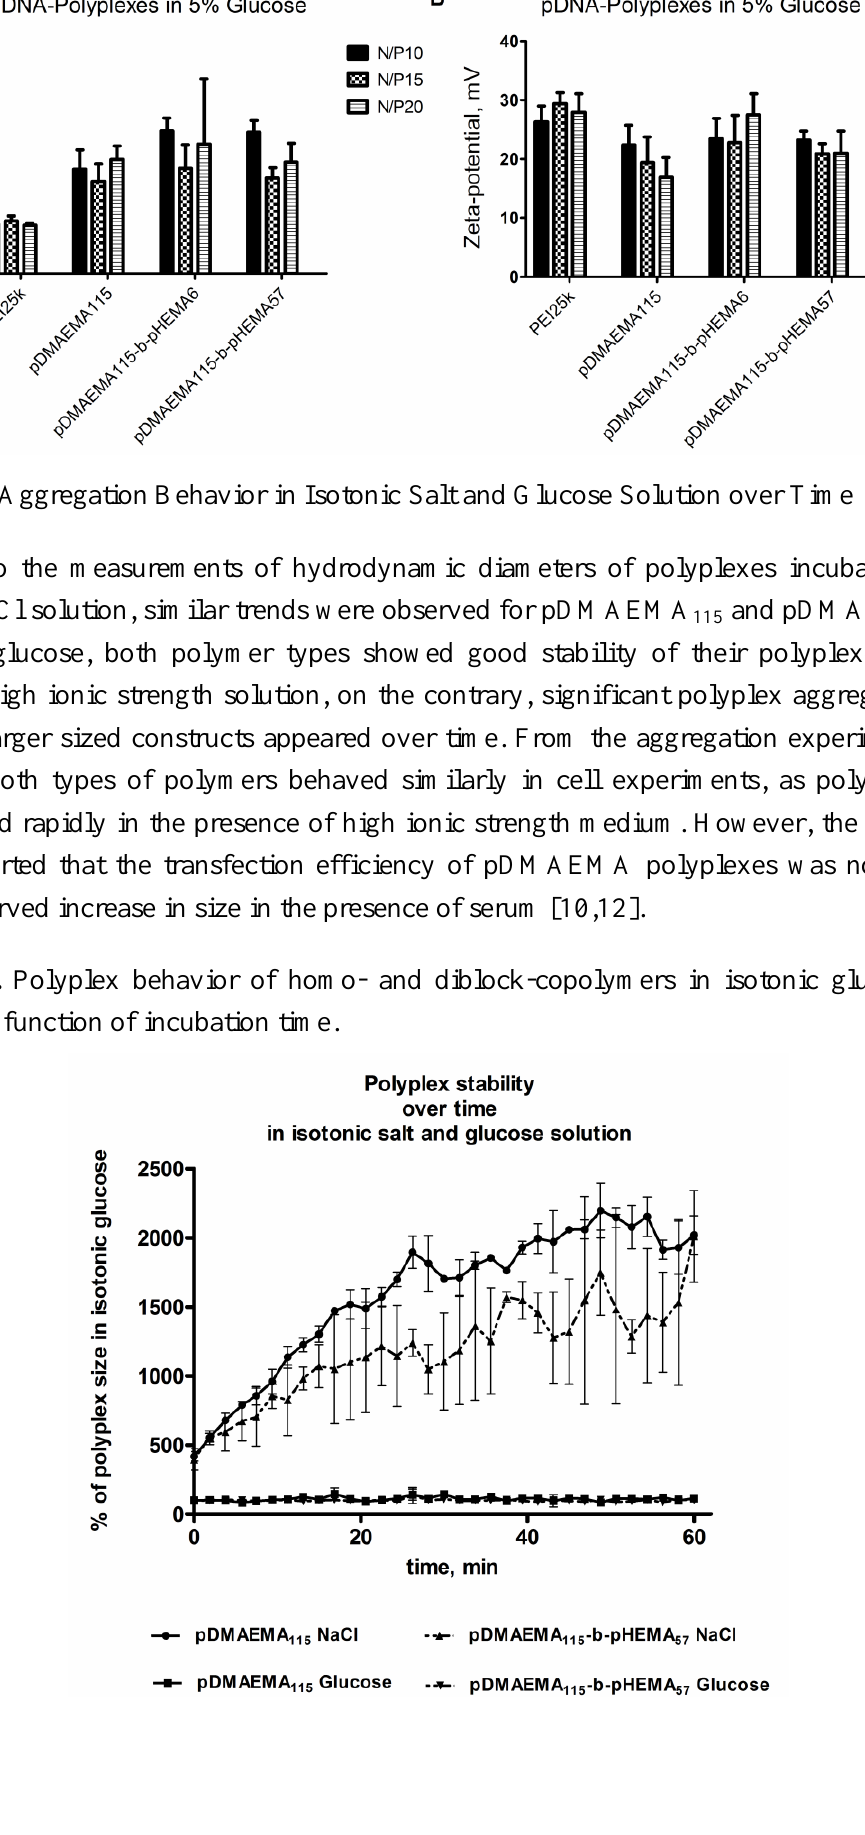
Figure 6. A , B . Polyplex sizes and zeta potential of pDMAEMA